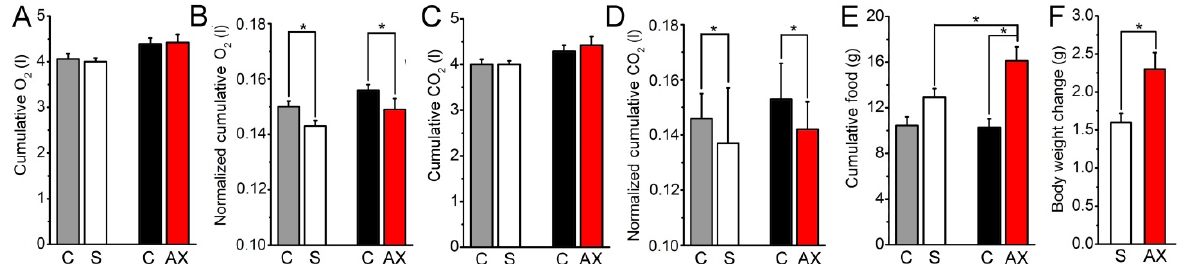
Figure 1. Metabolic effects of chronic astaxanthin feeding. ( A , B ) Actions on O 2 consumption without ( A ) and with normalization on body weight ( B ). Gray column: control group before sham feeding ( C ); hollow column: control group after sham feeding (S); black column: AX fed group before feeding of astaxanthin-containing chow ( C ); red column: AX fed group after feeding of astaxanthin-containing chow (AX). All panels have the same arrangement as above; ( C , D ) Effects on CO 2 consumption without ( C ) and with normalization on body weight ( D ); ( E ) Normalized actions on food intake; ( F ) Changes in body weight gain. * denotes significant differences at p < 0.05.